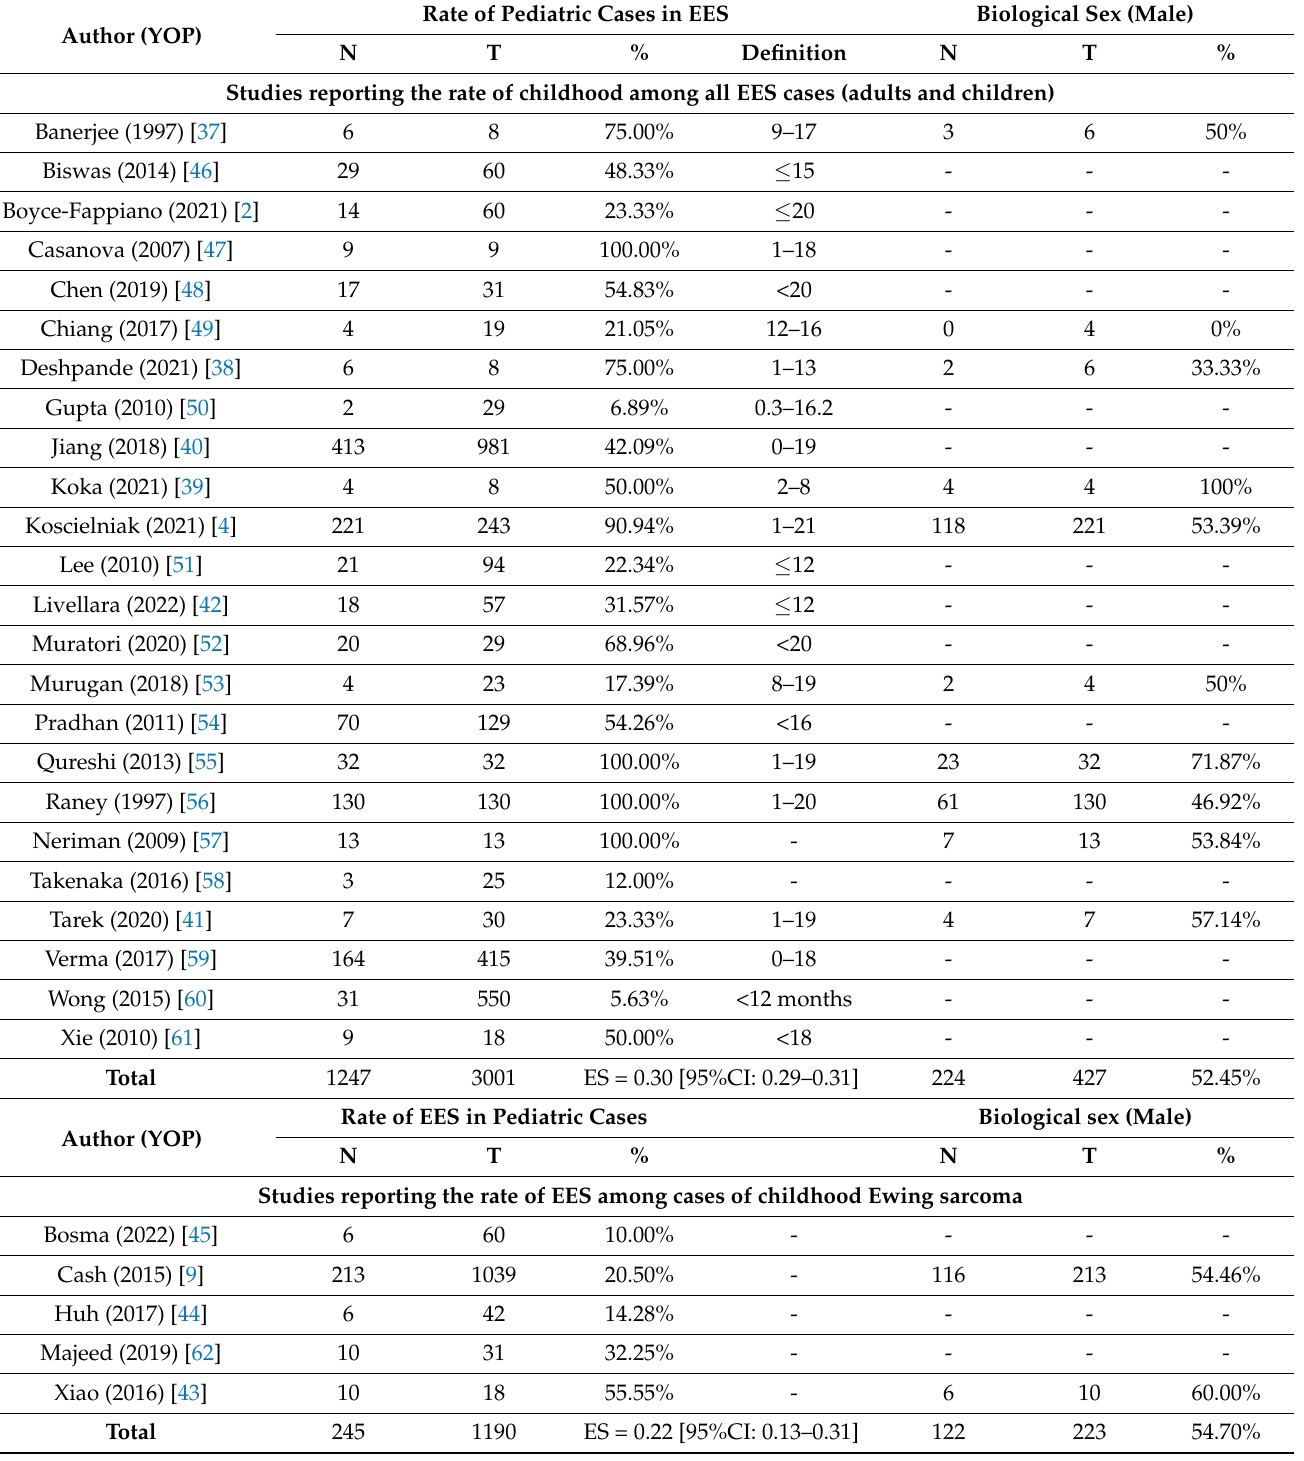
Table 2. The demographic characteristics of the included participants in each study with an overall estimation of the rate of the presentation with EES in